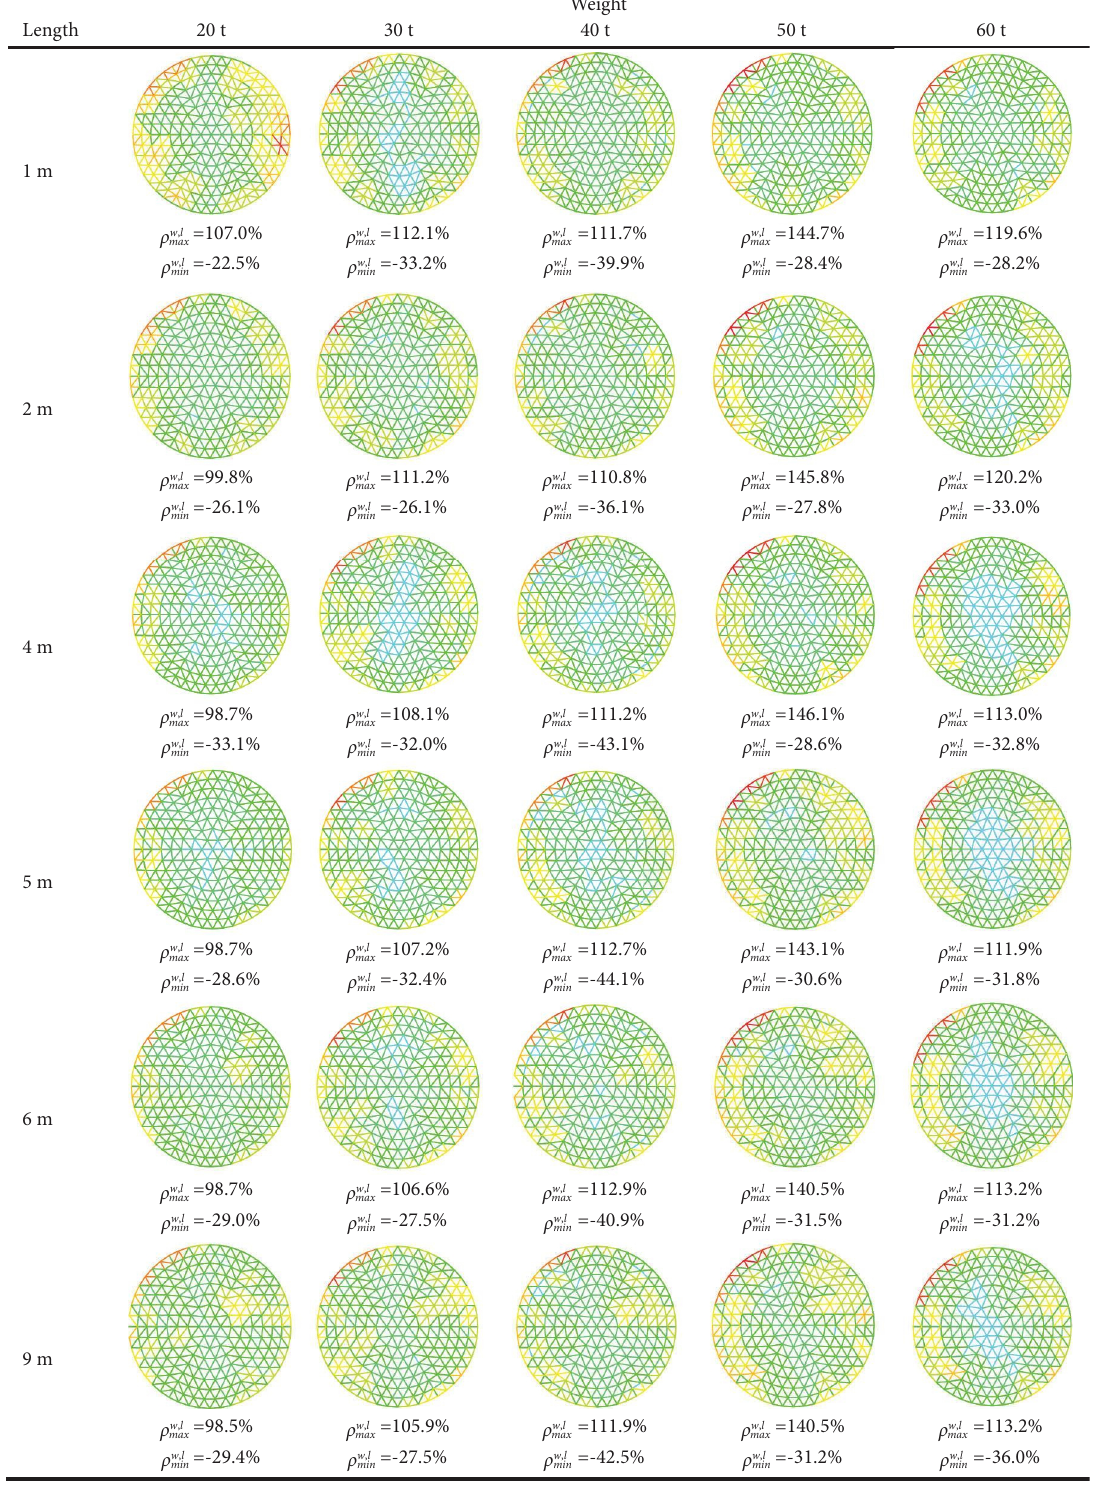
Table 3: Contours of the ρ w,l